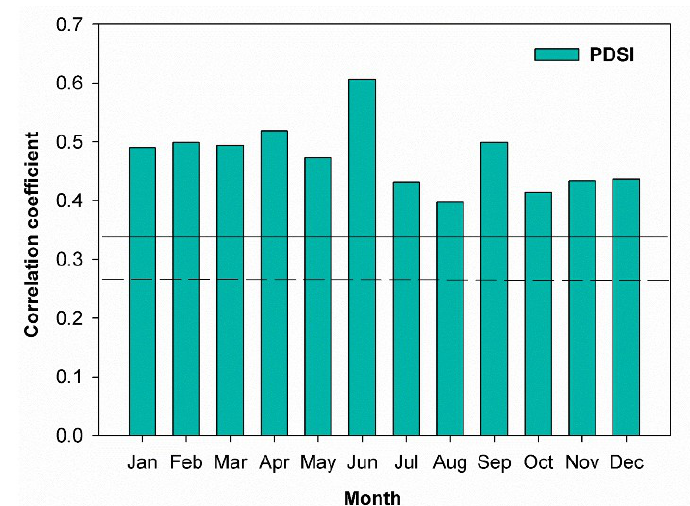
Figure 3. Correlations of the standard master chronology with monthly mean temperature (red bars), monthly total precipitation (blue bars) during the period of 1965–2016. The solid line and dashed line indicate p < 0.05 and p < 0.01, respectively.